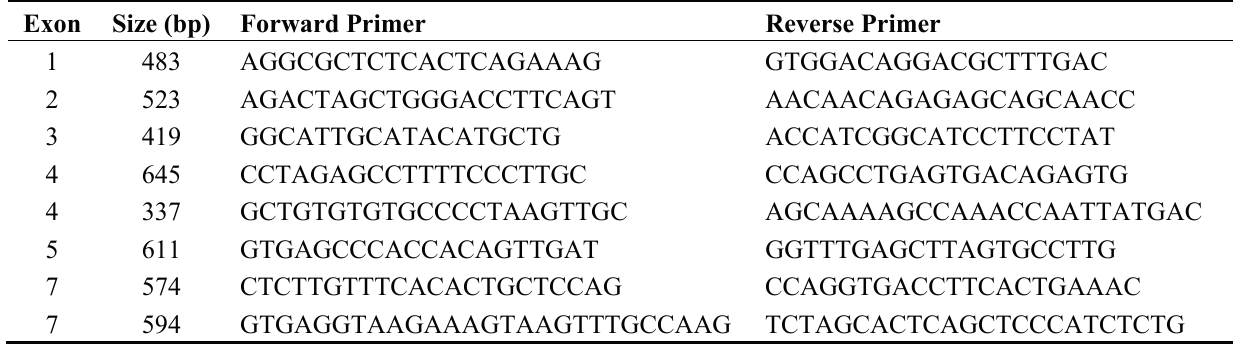
Table 1. Primers used to screen XPA mutations by direct